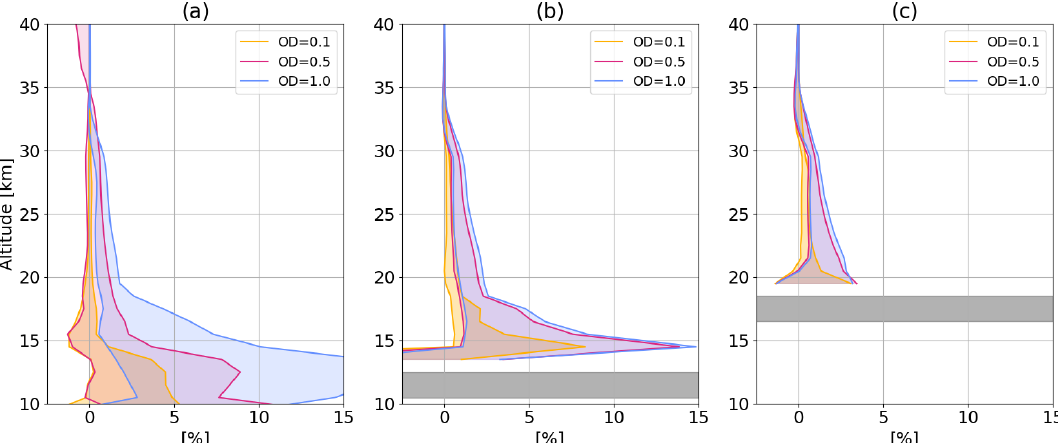
Figure 7. Relative difference between unperturbed and perturbed retrieved ozone profiles, with three different cloud scenarios ( (a) water cloud at 7km, (b) ice cloud at 10km, (c) ice cloud at 18km) represented by the gray horizontal bars for three optical depths (in different colors). The shaded areas give an idea of the spread of the differences as a function of latitude.